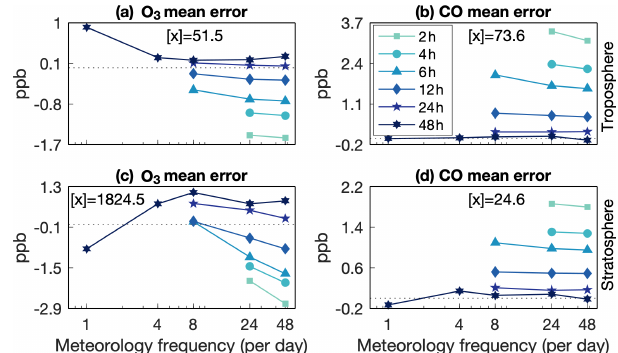
Figure 7. Globally and vertically averaged root-mean-square tem- poral error in tropospheric (a) ozone and (b) carbon monoxide and stratospheric (c) ozone and (d) carbon monoxide. For reference, the globally and vertically averaged temporal standard deviation of each field is shown in each panel.